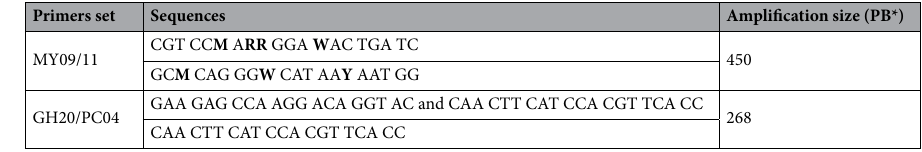
Table 6. HPV primers sequence. *M = A + C; R = A + G; W = A + T; Y + C + T*pb—pairs